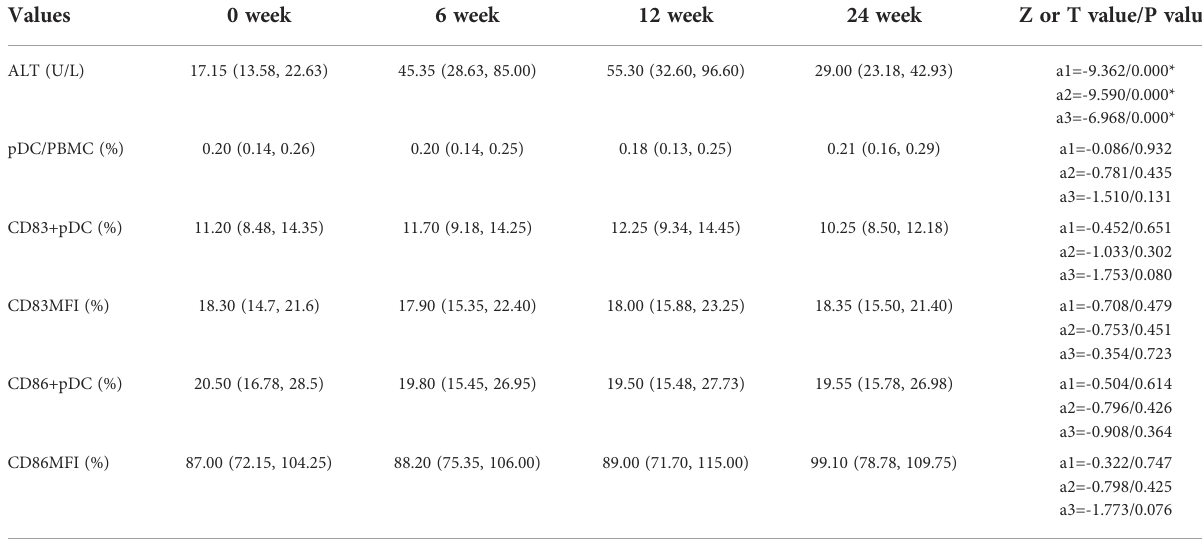
TABLE 2 ALT and pDC levels antepartum and postpartum of all patients.